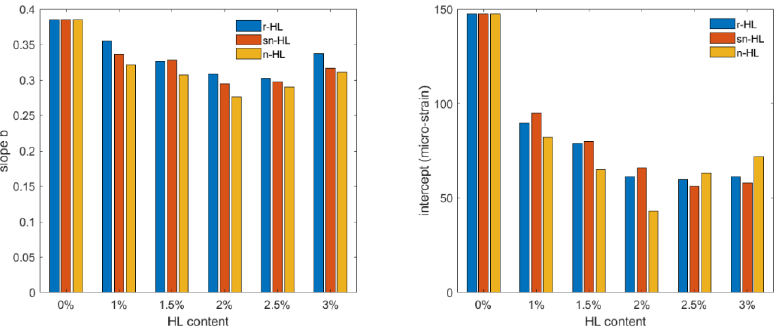
Figure 17. Comparison of the permanent deformation parameters, intercept and slope. Table 5. Permanent micro-strain ( p ) at 10,000 load repetitions.